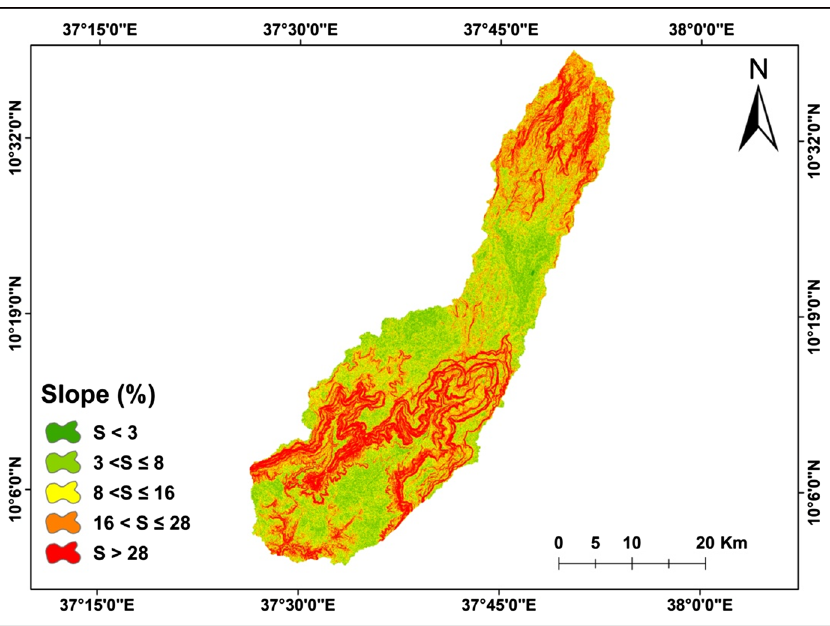
Fig. 5 Slope map of the study